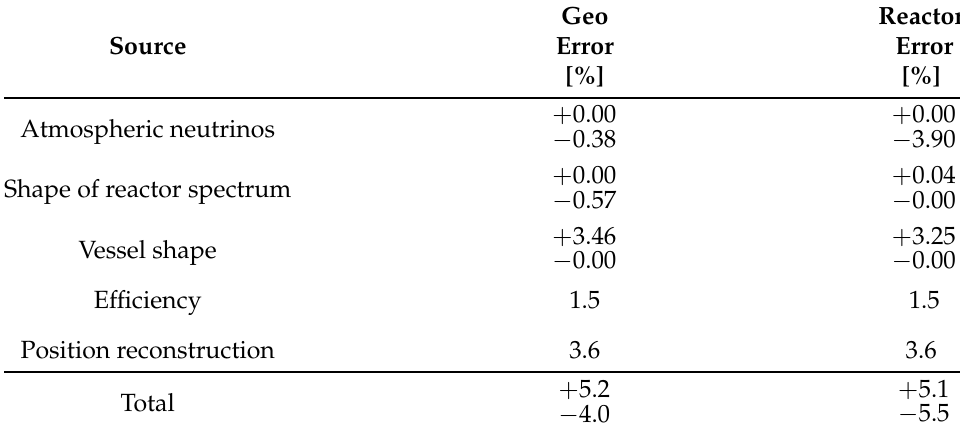
Table 9. Summary of the different sources of systematic uncertainty in the geoneutrino and reactor antineutrino measurement. Different contributions are summed up as uncorrelated. From